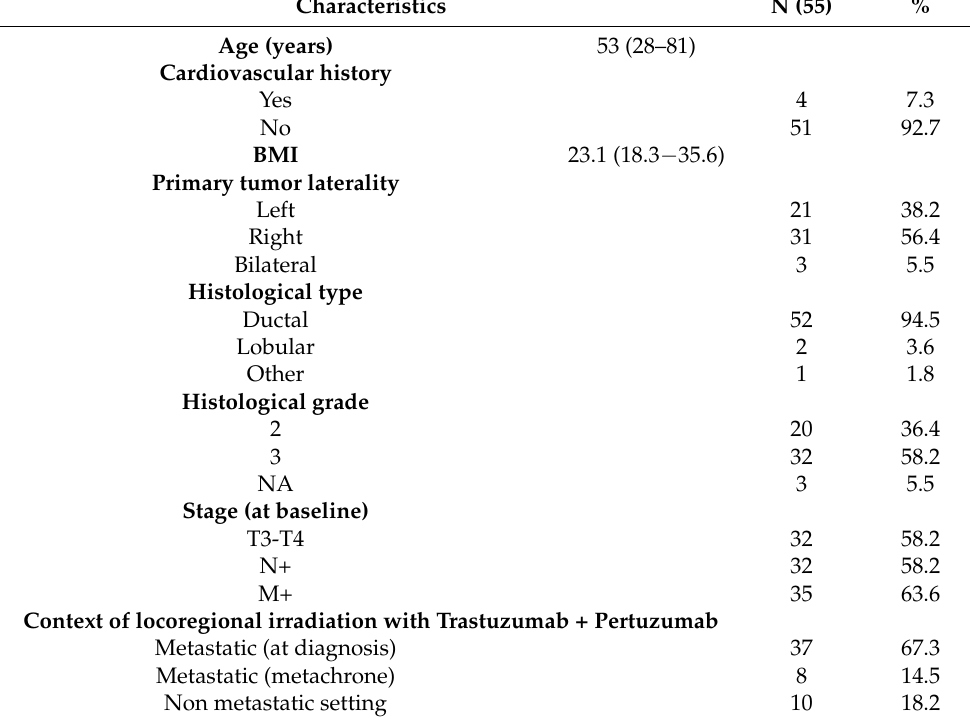
Table 1. Study population (patients received curative dose local and/or lymph nodes radiotherapy. Characteristics N